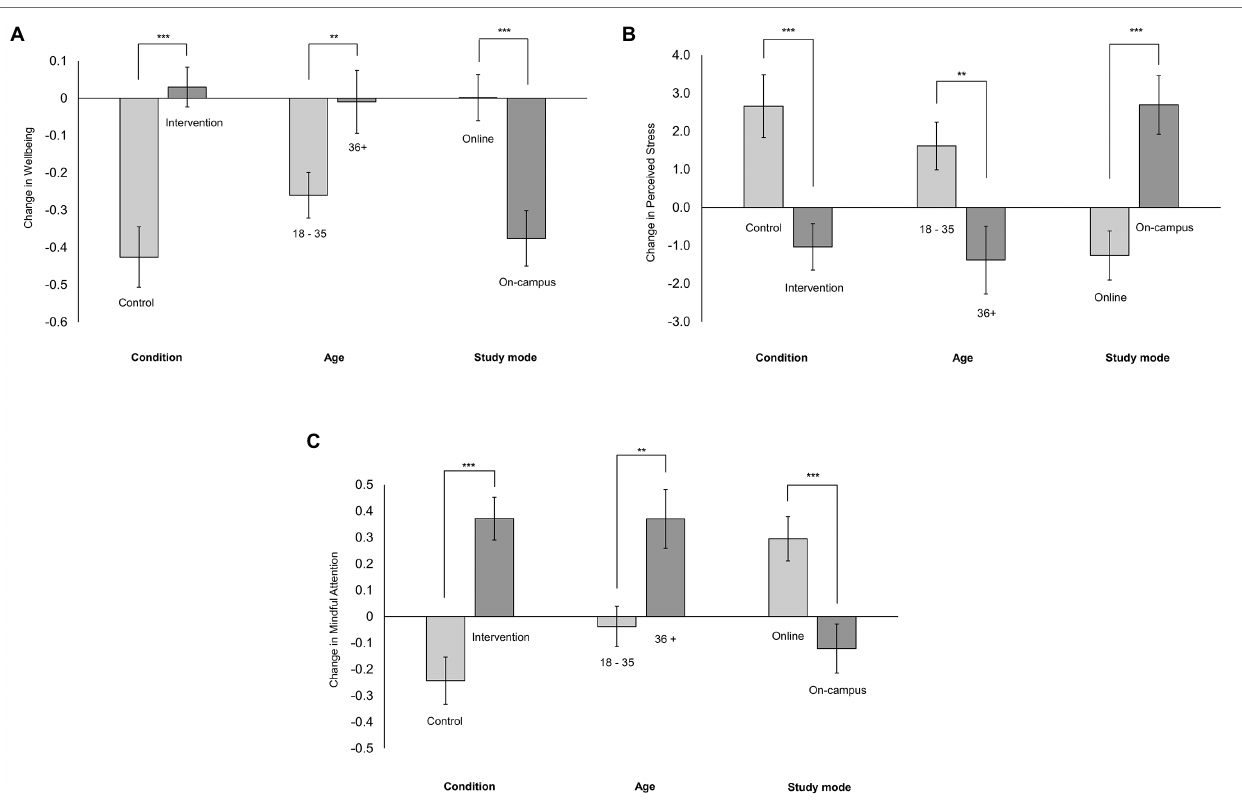
FIGURE 2 | Group differences for condition, age and study mode in (A) wellbeing, (B) stress and (C) mindful attention. Change = Time 2 − Time 1. Positive change values indicate an increase in scores from Time 1 to Time 2. Negative change values indicate a decrease in scores from Time 1 to Time 2. Standard errors are represented in the figure by the error bars attached to each column. ** p < 0.01 and *** p < 0.001.